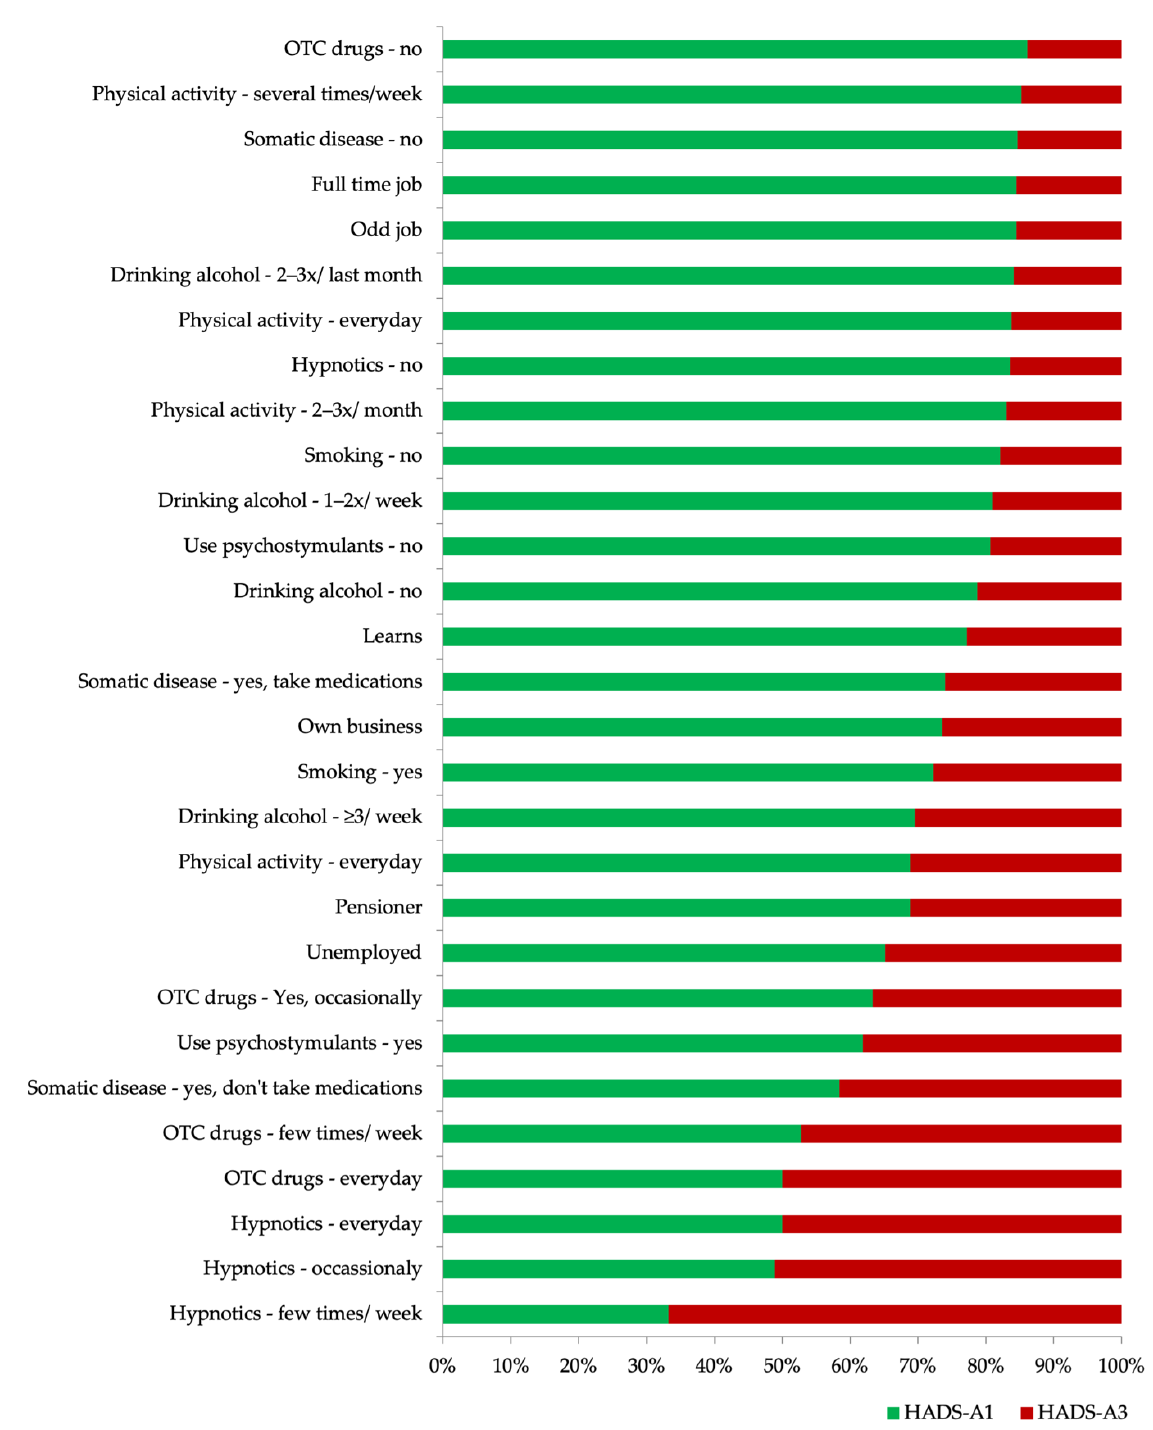
Figure 5. Data sorted by the percentage of anxiety disorders (HADS-A3 / HADS-A1) in particular subgroups of risk modifying factors that were statistically significant (the significance level for the effect of psychostimulants is p < 0.05; for other factors p <